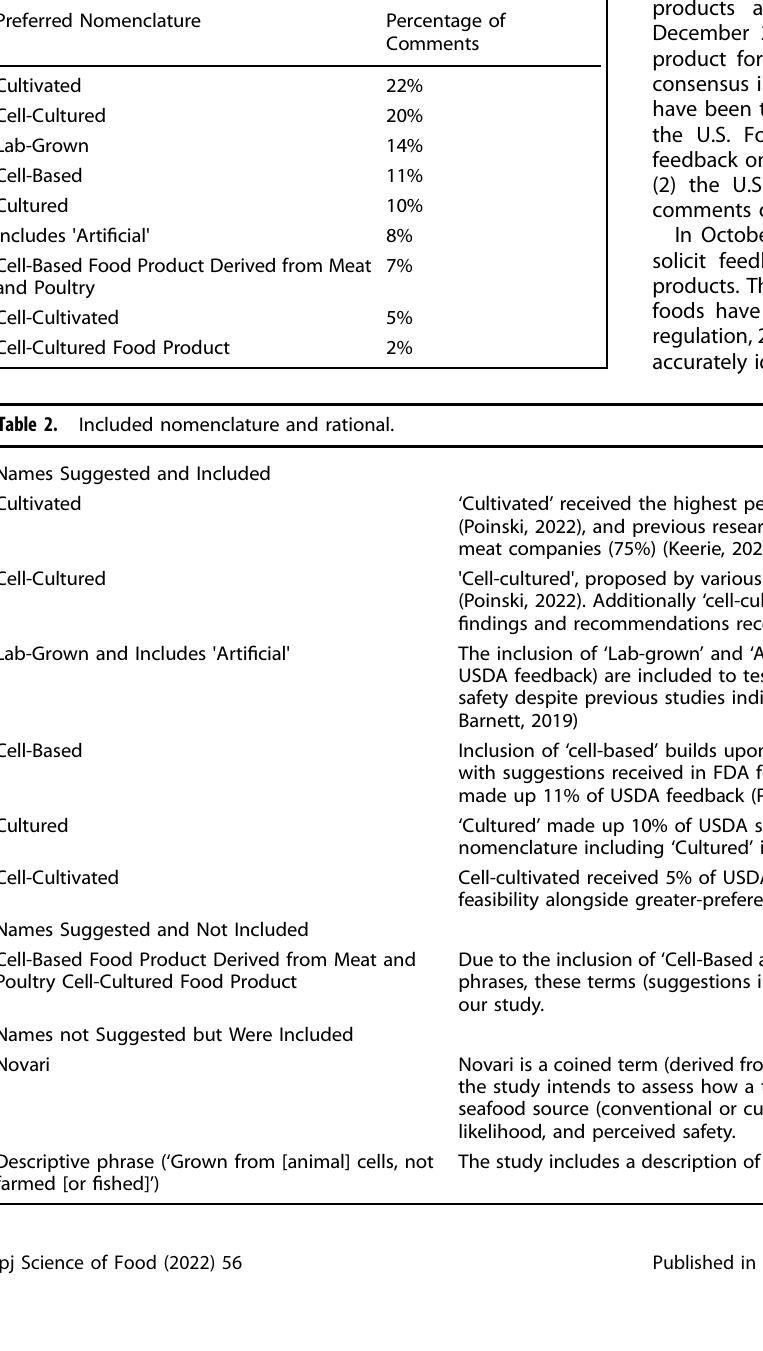
Table 1. Names suggested by at least two contributors to the USDA call for feedback on labeling cultivated meat and poultry 34 . 158.